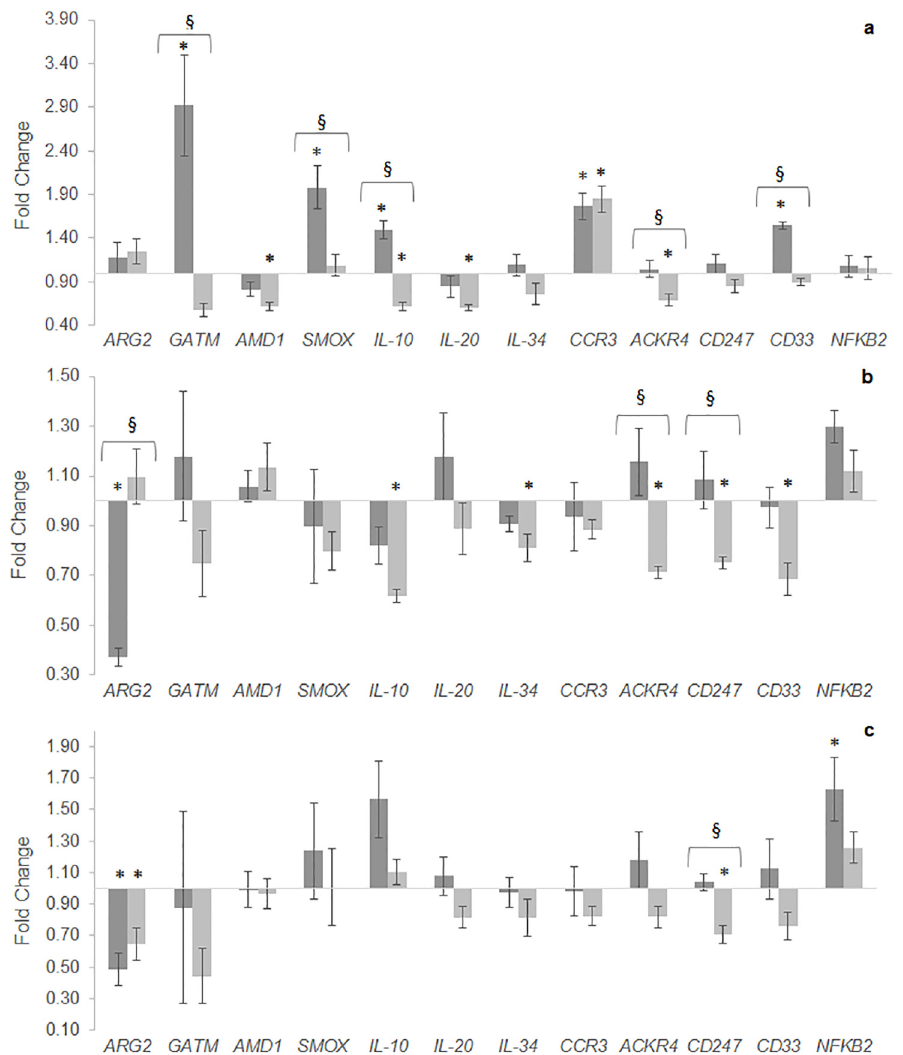
Fig 4. Quantitative expression of immune-related genes in spleen (a), anterior (b) and posterior (c) intestine of European sea bass fed different diets for 29 days. Data are presented as means ± SEM (n = 6). Bars represent fold change of Arg1 (dark grey columns) and Arg2 (light grey columns) relatively to the CTRL group, previously normalized to endogenous β -Actin expression levels. Asterisks indicate significant differences relatively to CTRL group; section sign indicates differences between arginine supplementation levels (One-way ANOVA; P <